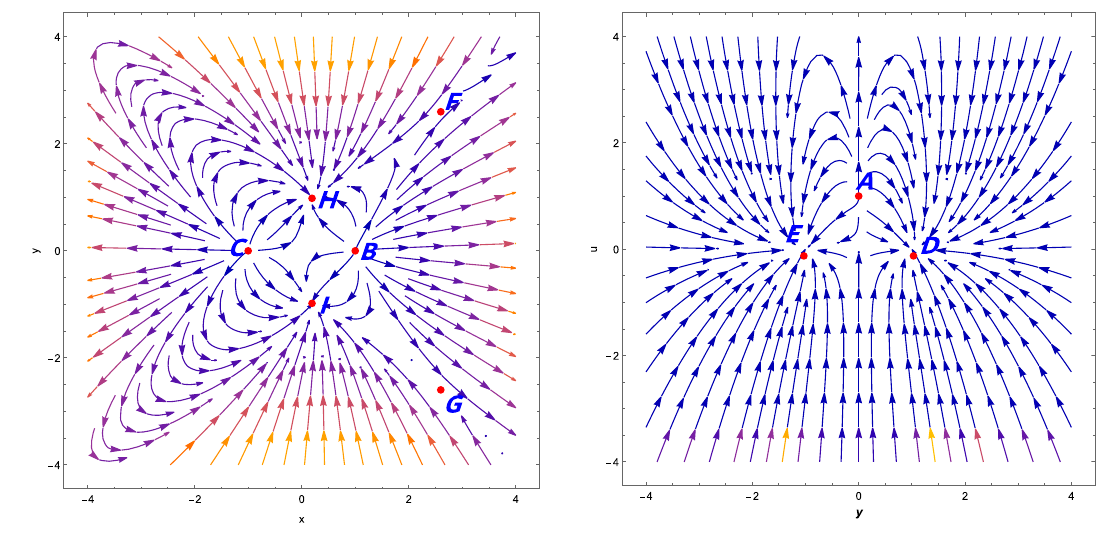
(cid:13) 2 and right side plot parametric values are x = 0, ρ = 0, 9